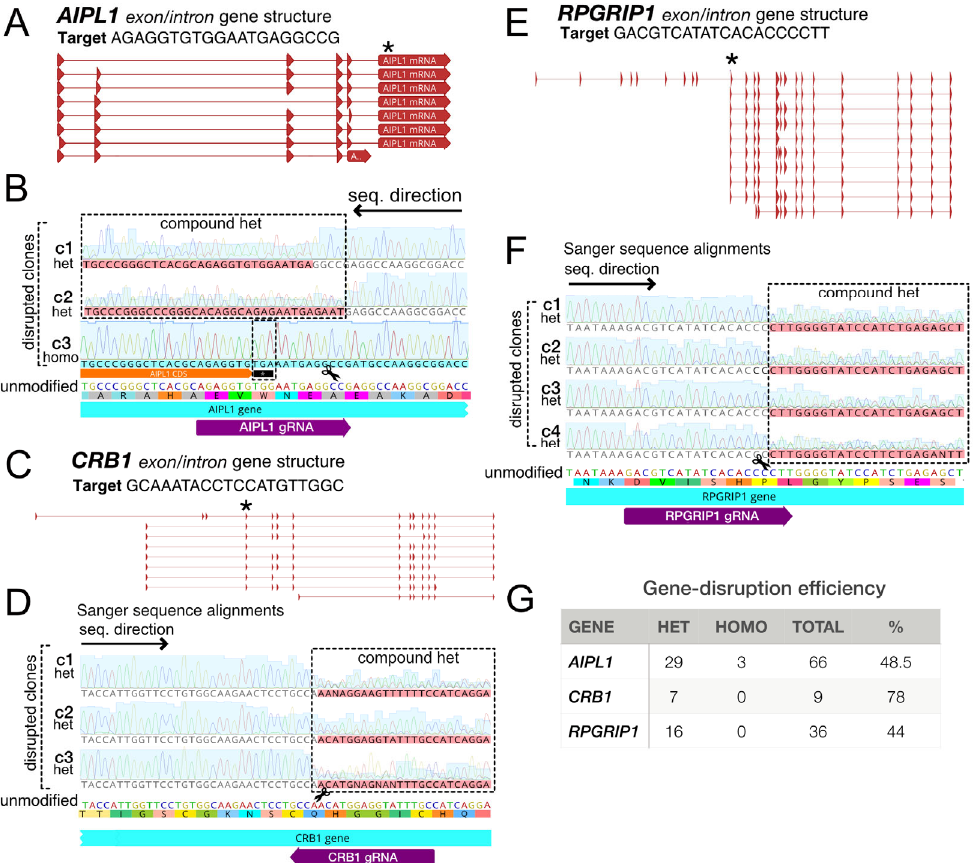
Figure 7. Targeted mutagenesis for generating disease-relevant mutant PSCs. ( A ) Gene organization of the intron/exon structure of the AIPL1 gene and CRISPR targeting location of the final exon near the W278 locus as indicated by an asterisk *. ( B ) Sanger sequence chromatograms (sequenced from right to left) from select clones aligned to unmodified sequences (below) indicate compound heterozygous (c1-2) and homozygous W278X conversion (c3). ( C ) Intron/exon structure of the CRB1 gene and CRISPR targeting at an exon common to 8 out of 9 isoforms. ( D ) Sanger sequence alignments (sequenced from left to right) of the targeted CRB1 locus for several clones (c1-3). ( E ) The RPGRIP1 gene intron/exon structure is displayed with a CRISPR-targeted common exon (*). ( F ) Confirmation of mutagenesis at RPGRIP1 by Sanger sequence alignments (sequenced from left to right) for clones 1–4 (c1-4). ( G ) A table illustrating mutagenesis efficiencies at the AIPL1, CRB1 and RPGRIP1 loci. Efficiency (%) = (heterozygous + homozygous clones/total sequenced clones) * 100. The dotted boxes around alignments highlight gene disruption in various clones while pink shading indicates compound heterozygosity from different reading frames at one or both alleles. Horizontal black arrows indicate the sequencing